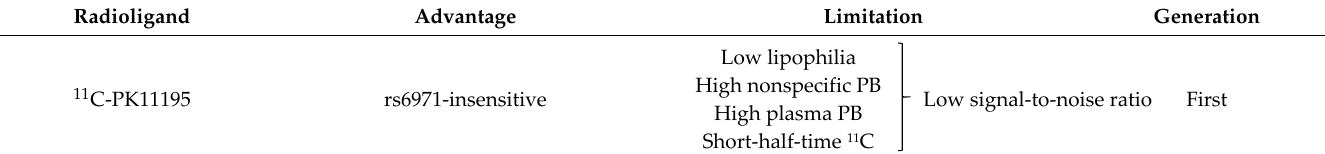
Table 1. A summary of the different generation of TSPO radiotracers from Vivash and O’Brien [43].